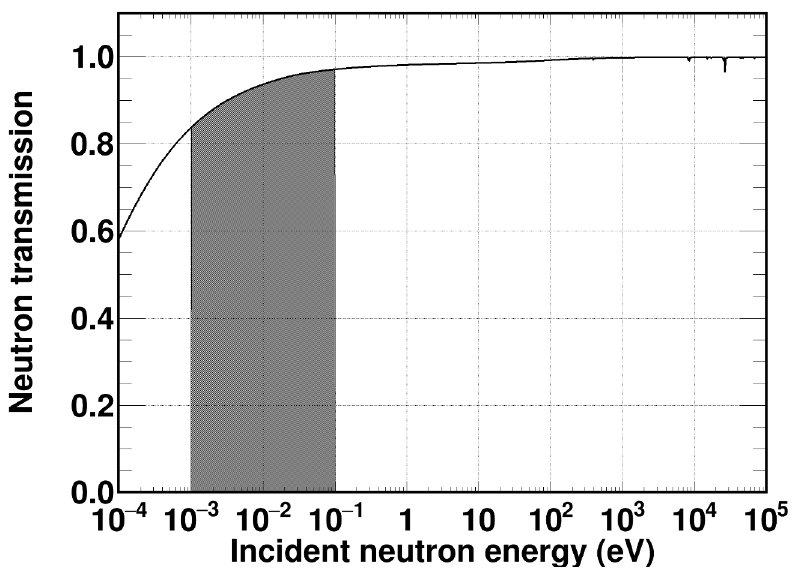
Figure 6. Neutron transmission through a 1 . 4 mol/L, 1 cm long and 1 . 2 mm in diameter cylindrical sample made of DCl. The grey shaded area corresponds to the main area of interest where a 88 Zr resonance is expected. ENDF/B-VIII.0 cross sections for 2 H, 35 Cl and 37 Cl were